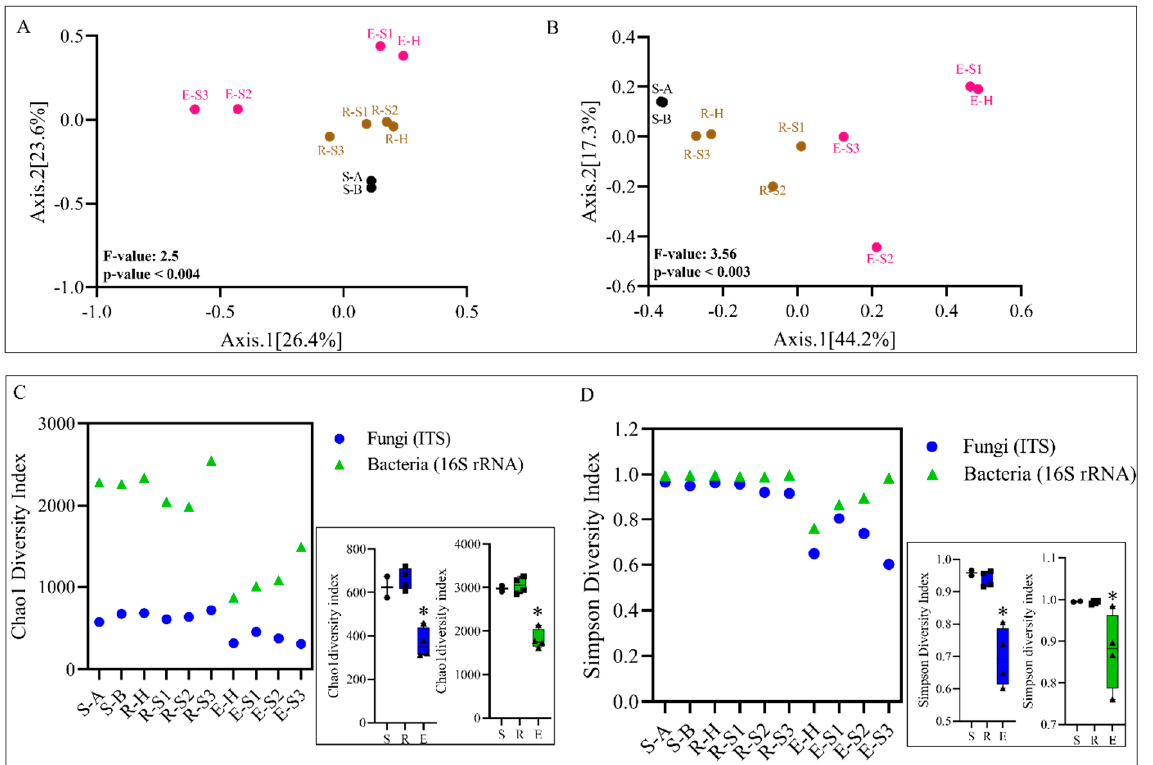
Figure 2. Alpha and beta diversity of the mycobiome and microbiome of soybean roots. ( A , B ) Con- strained Analysis of Principal Coordinates (PCoA) of ITS ( A ) and 16S ( B ) diversity in the soil (S-A and S-B), rhizosphere (R-H, R-S1 to R-S3), and endosphere (E-H, and E-S1 to E-S3) of plants healthy or at diverse stages of taproot decline disease. Insets show PCoA 3D plots. Cumulative-sum scaling transformed reads were used to calculate Bray–Curtis distances, and significance was assessed by PERMANOVA ( p -value < 0.05). ( C , D ) Alpha diversity was calculated for 16S rRNA and ITS datasets using the Chao1 and Simpson diversity measures. Insets show cumulative values for soil, rhizosphere, and endosphere samples. The significance of the alpha diversity profiling was assessed through ANOVA ( p -value < 0.05). Asterisks (*) show statistical significance.